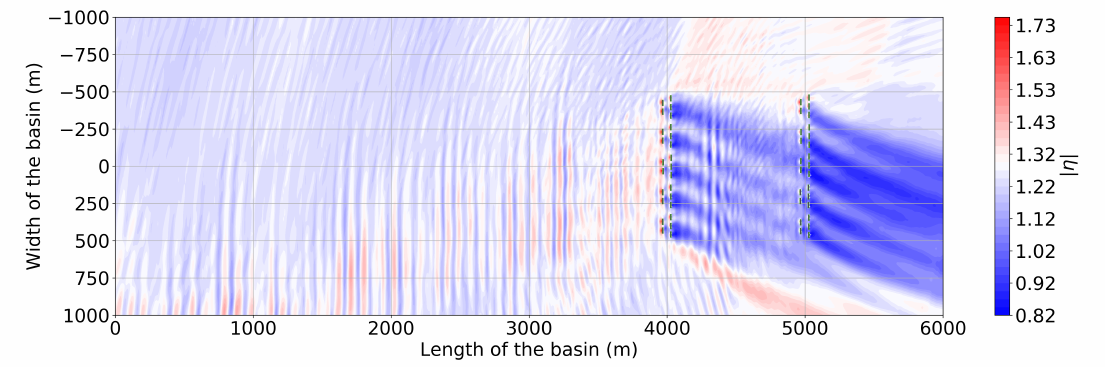
Figure 15. Coupled total | η | for the mean winter wave H m 0 = 2.55 m, T p = 11.71 s, and β = − 20 ◦ for a 50 WEC 10-Array farm.